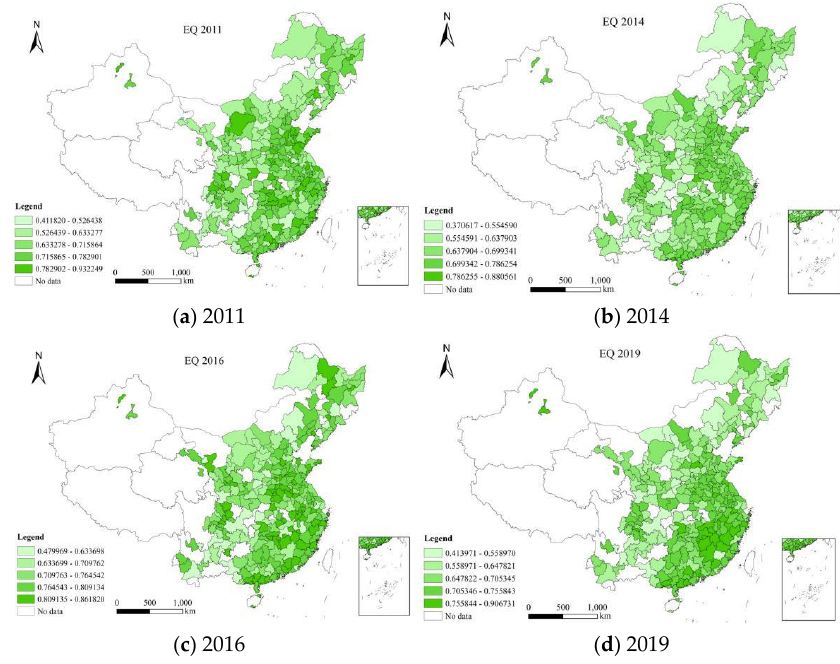
Figure 1. Environmental quality of 275 cities in China in (a)2011, (b)2014, (c)2016 and (d)2019.